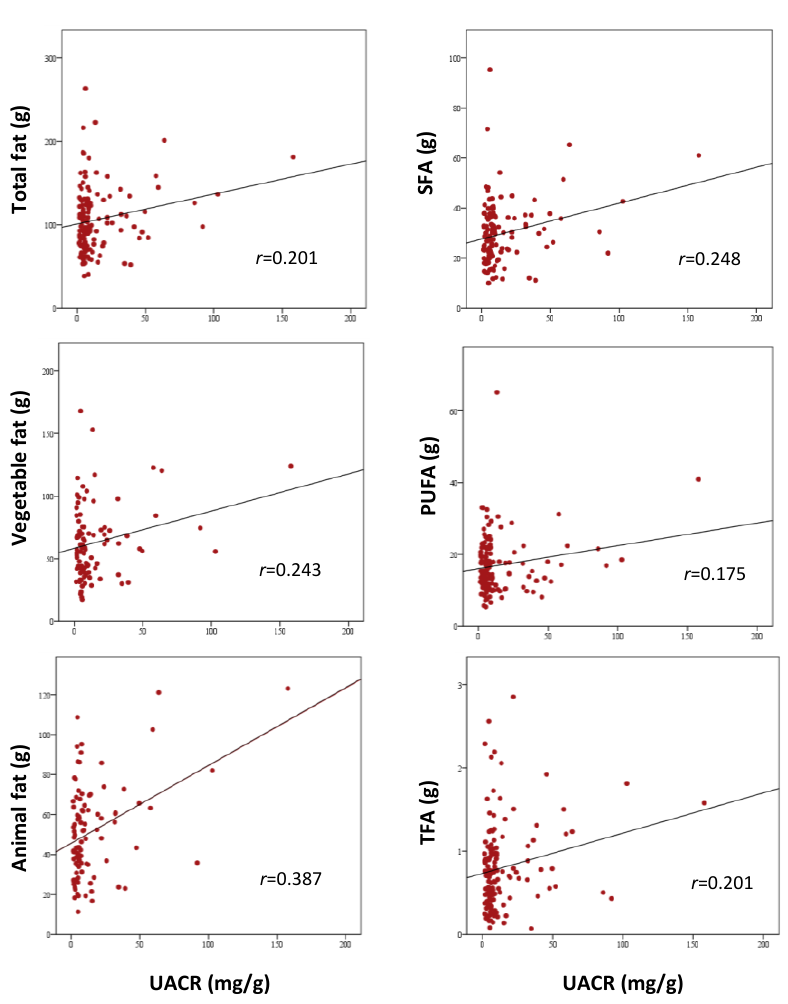
Figure 1. Pearson’s correlation analysis between UACR and dietary fats (all p < 0.05). Abbreviations: PUFA: polyunsaturated fatty acids; SFA: saturated fatty acids; TFA: trans fatty acids; UACR: urine albumin-to-creatinine ratio.